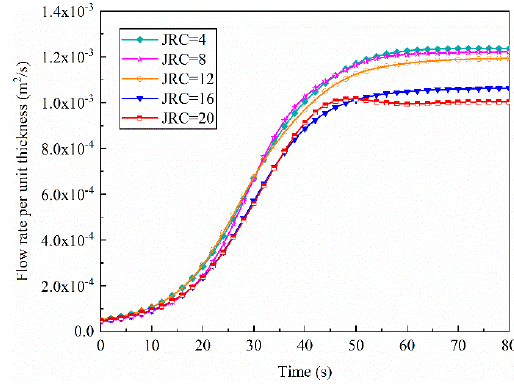
Figure 15. The flow rate per unit thickness curves for different joint roughness coefficients (JRCs).